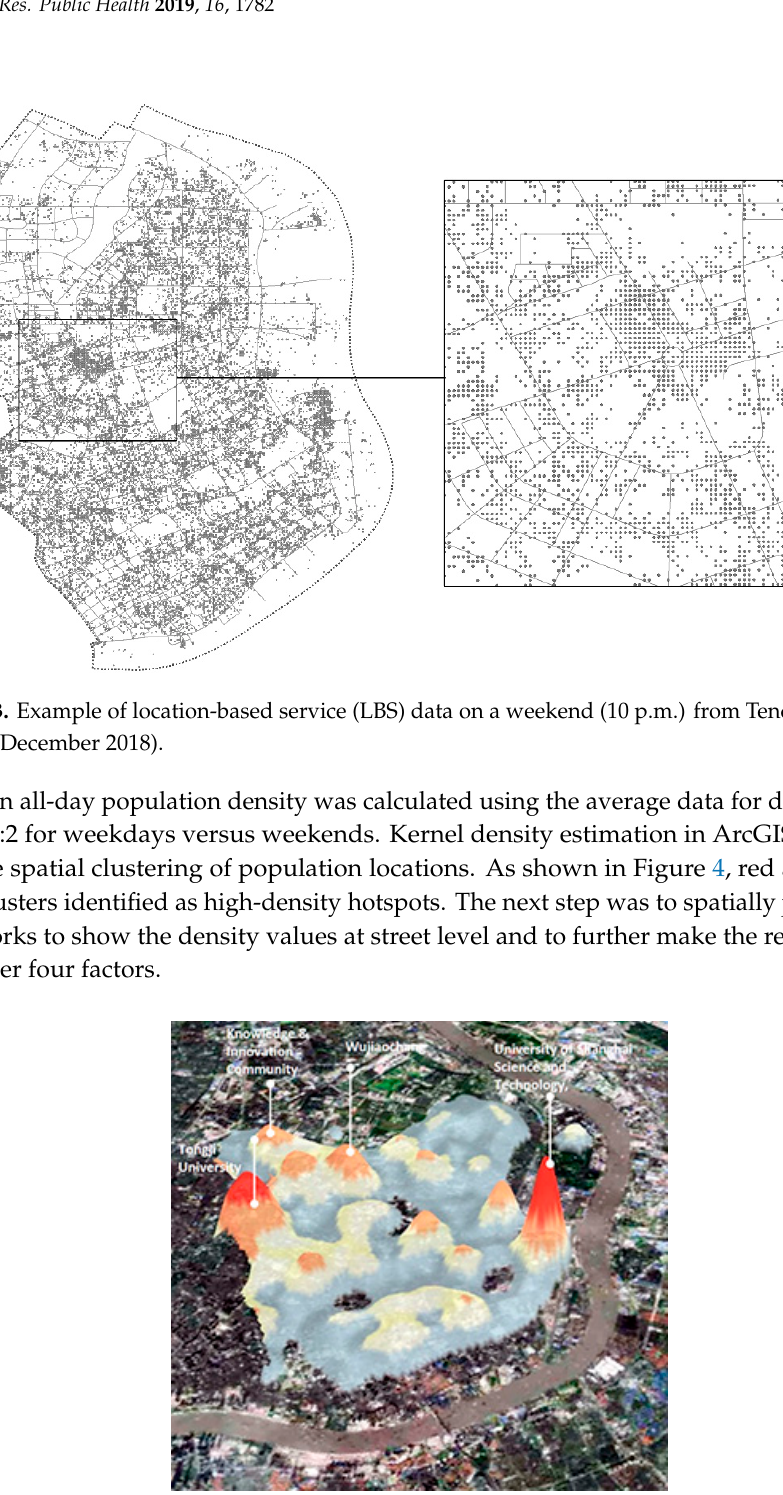
Figure 4. Kernel density hotspot map showing average population density of Yangpu District.